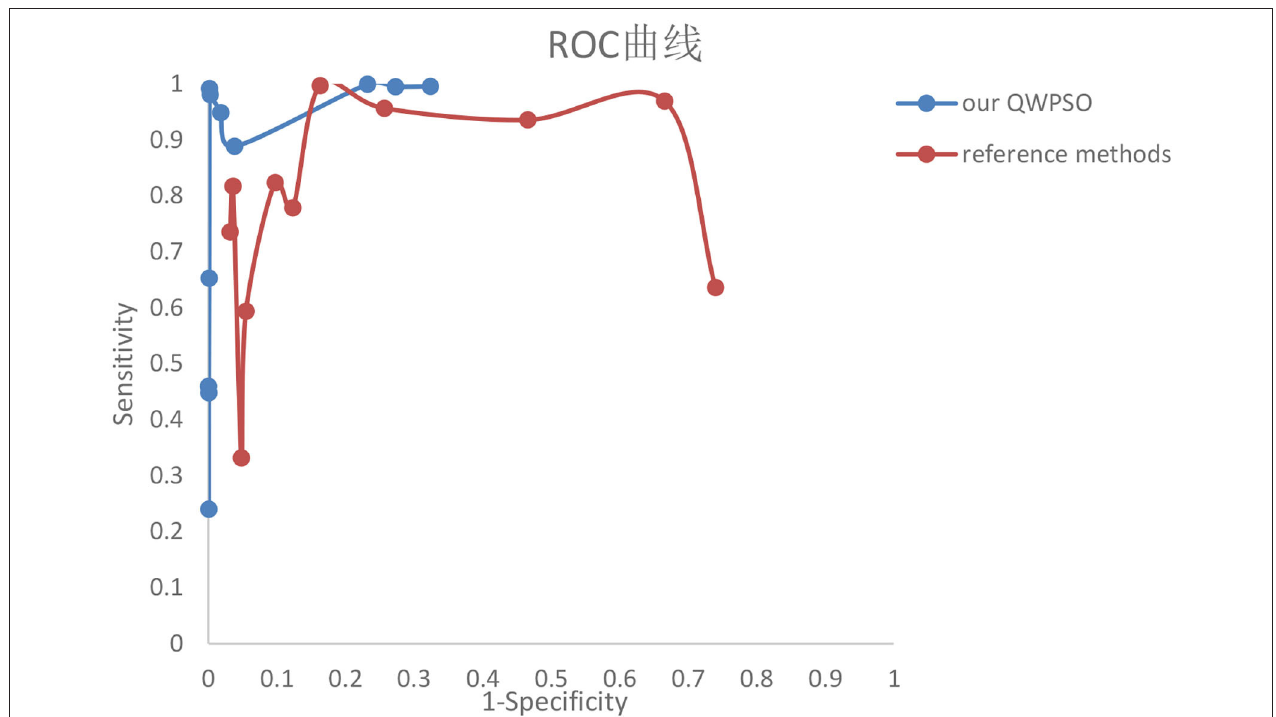
FIGURE 5 | The receiver operating characteristic (ROC) curve of the proposed QWPSO and reference methods.